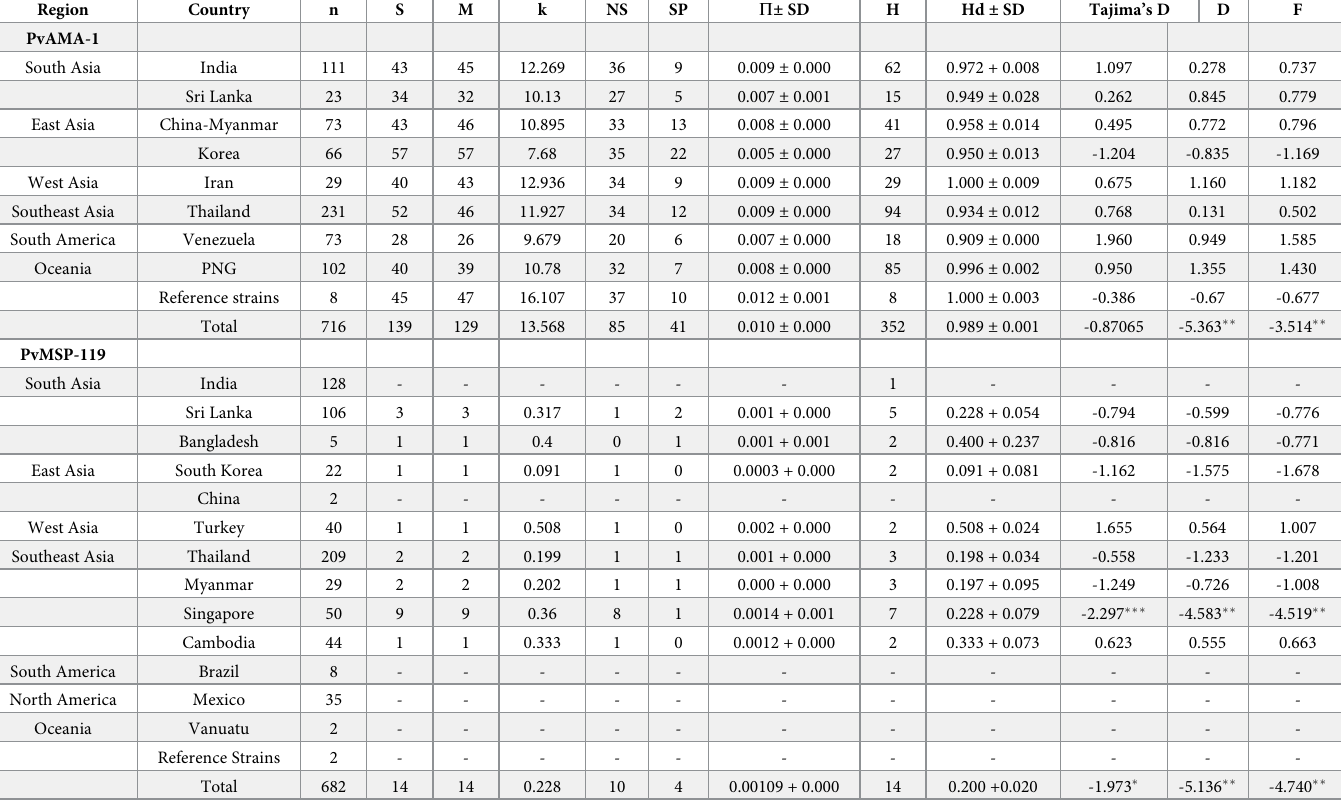
region in worldwide 19